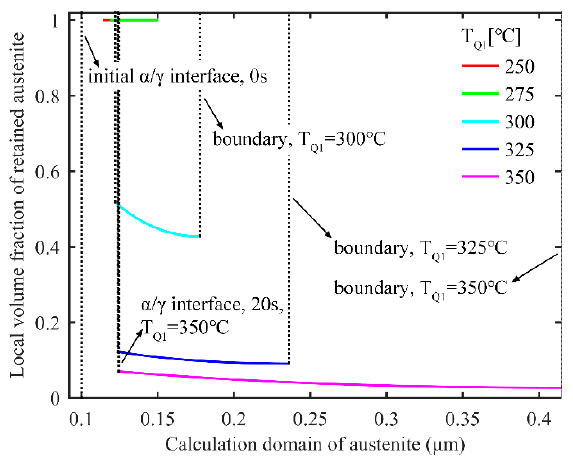
Figure 4. Local volume fraction of retained austenite after final quenching in the one-stage Q-P process. The partitioning temperature and time are 425 ° C and 20 s, respectively.